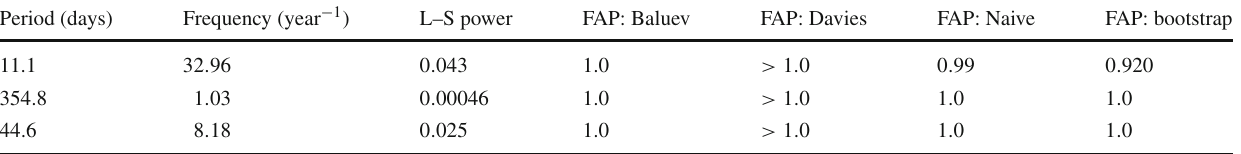
Table 1 99m Tc L–S powers and FAP for our data using multiple meth- ods: Baluev, Davies, Naive, and Bootstrap. We show the corresponding values of the period and frequency for the most significant peak (cor- responding to the period of 11.07 days), followed by the period closest